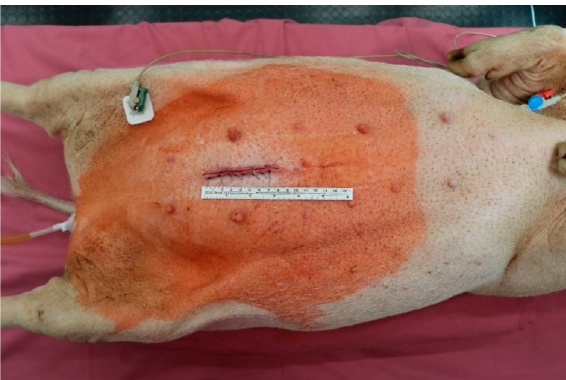
Figure 7. Operative setup after closure of the abdominal wall. The animal was placed in a supine position. The picture shows the mini-laparotomy of 7 cm length.